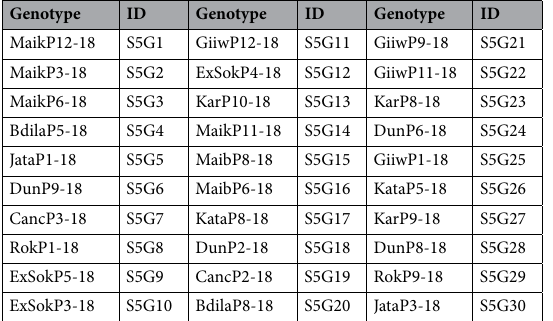
Table 1. List of selected genotypes used in this study. Maik Maikai, Bdila Bidillali, Jata Jatau, Dun Duna, Canc Cancaraki, Rok Roko, ExSok Exsokoto, Giiw Giiwa, Kar Karu, Maib Maibergo, Kata Katawa.